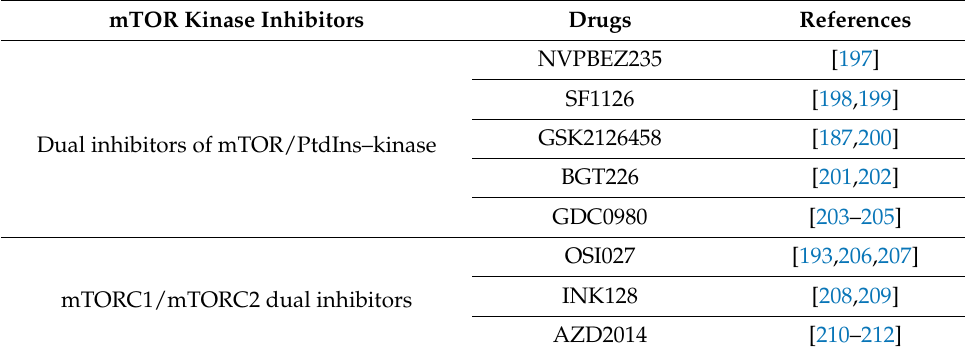
Figure 4. A comparative analysis of adenoma epithelial cell with defective antigen-presenting cells, role of beta-catenin, and rapamycin in the induction and control of cancer respectively. Beta-catenin and rapamycin inhibited cell growth and development of tumor induced by Wnt by inhibiting mTOR signalling. Table 3. mTOR kinase inhibitors with therapeutic effects in cancer confirmed both in vitro and in